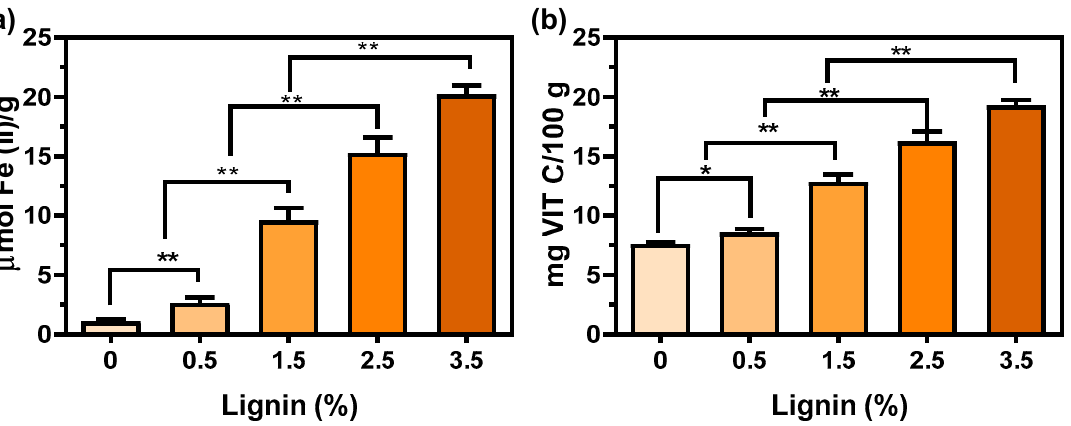
Figure 5. ( a ) The ferric reducing ability of plasma (FRAP) value for the printed composites, and ( b ) The vitamin C equivalent antioxidant activity of the composites. ( n = 3).